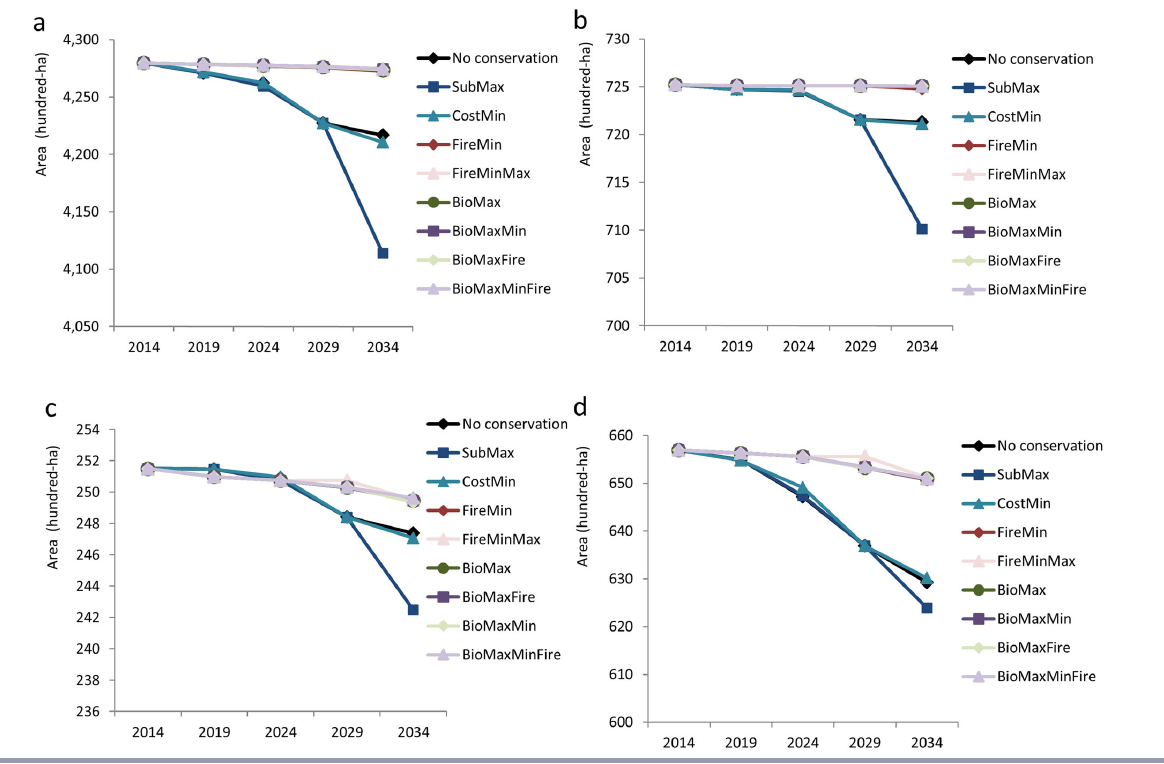
Fig. 4 . Area of major vegetation types, including (a) shrubland, (b) forest and woodland, (c) riparian and wetland, and (d) grassland over time for all conservation selection